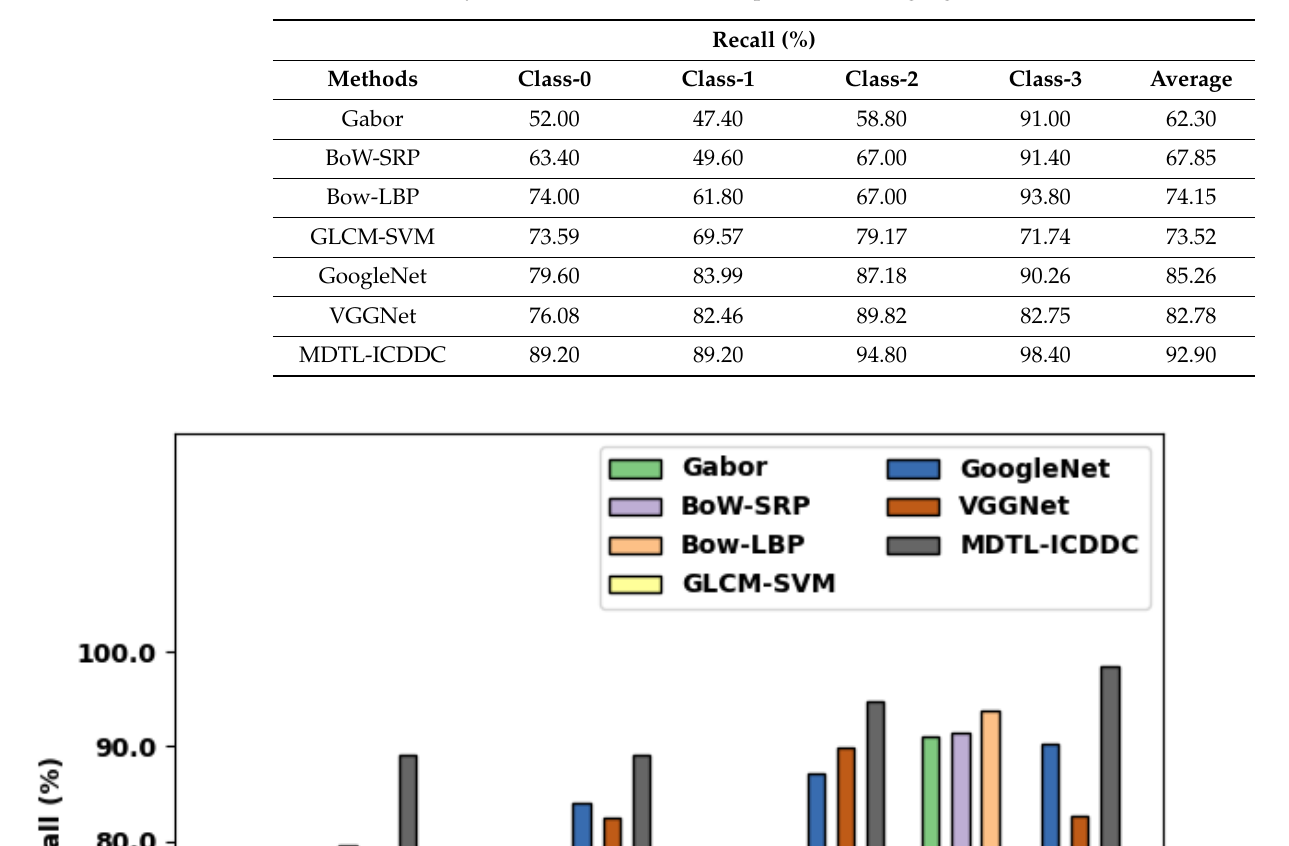
Table 4. Recall analysis of MDTL-ICDDC technique with existing algorithms under various classes.